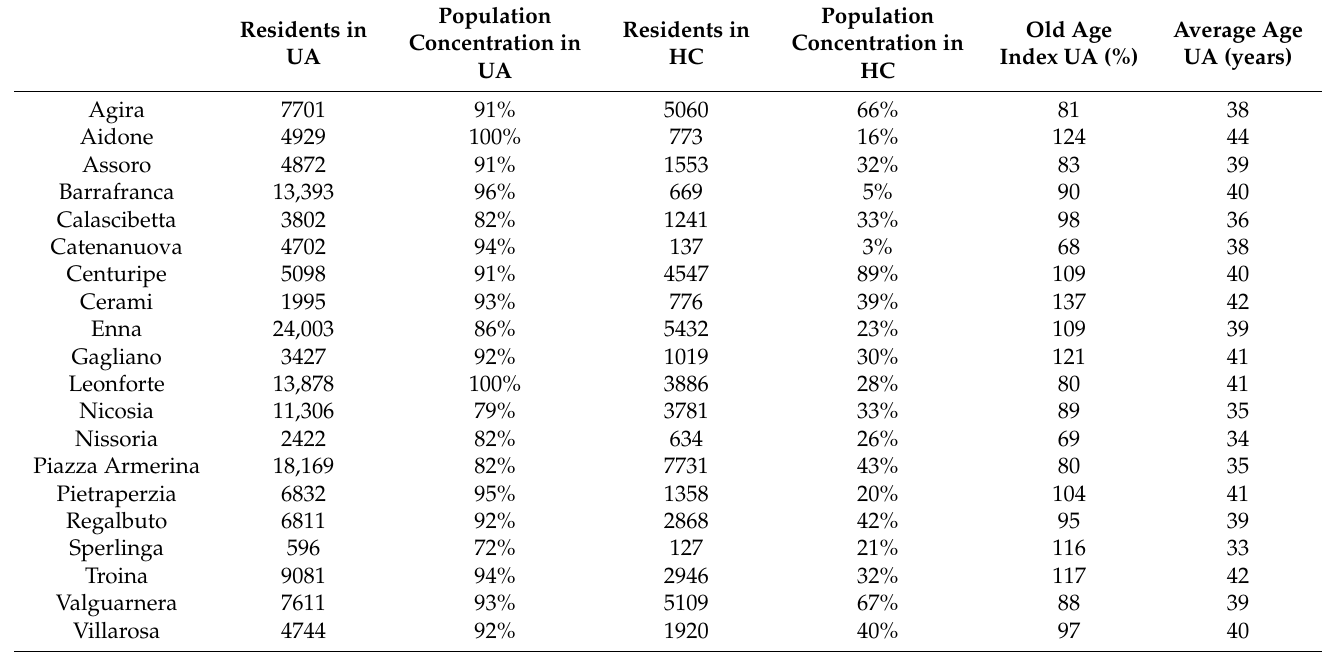
Table 4. Data and indices concerning the distribution of the Enna land district population between the 20 municipalities.